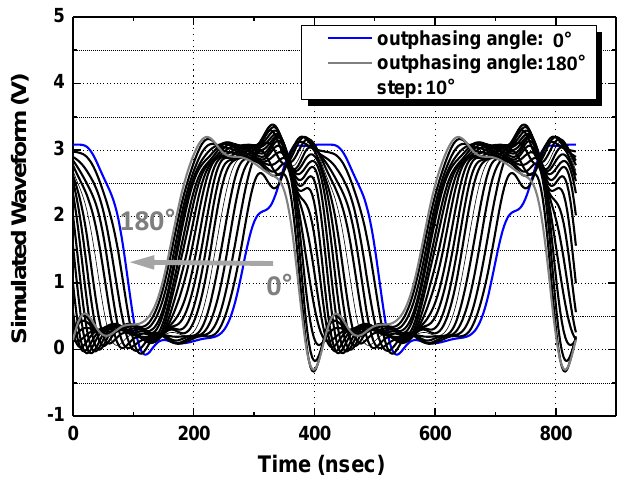
Figure 11. Simulated waveforms of the drain voltage.